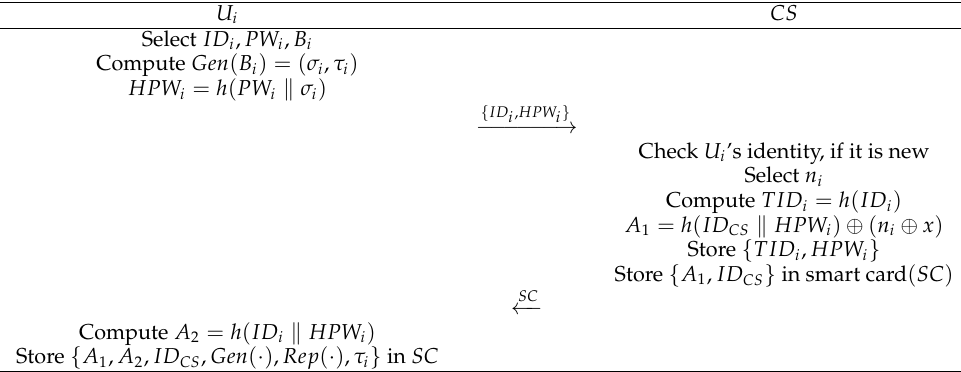
Figure 3. User registration